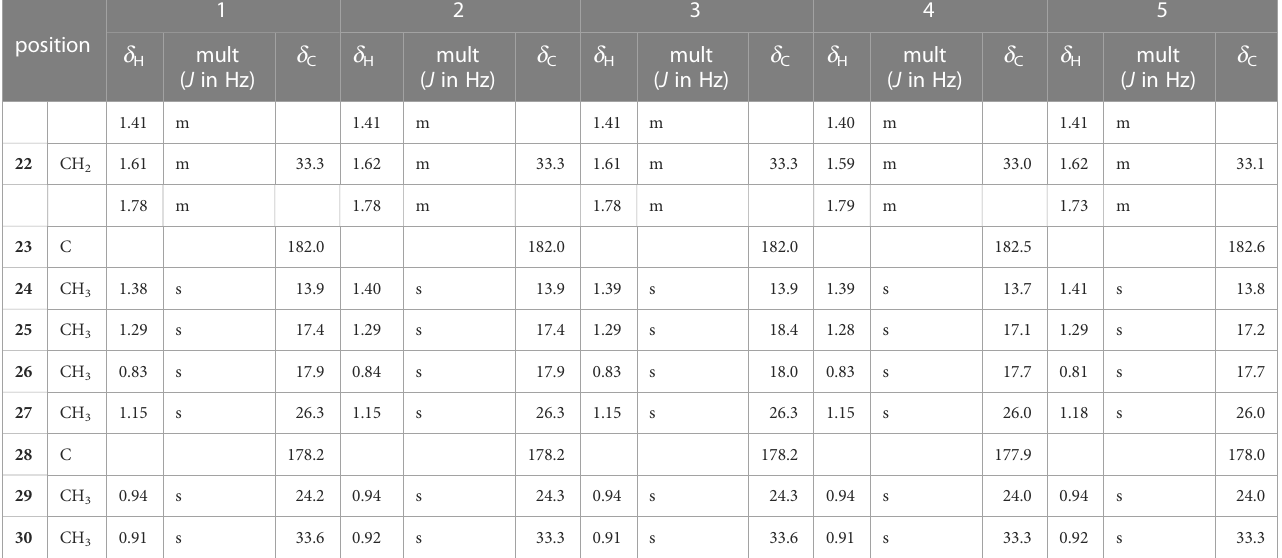
TABLE 2 1 H and 13 C NMR spectroscopic data of the sugar and 3-HB moieties of pannosides A – D (1 – 4).